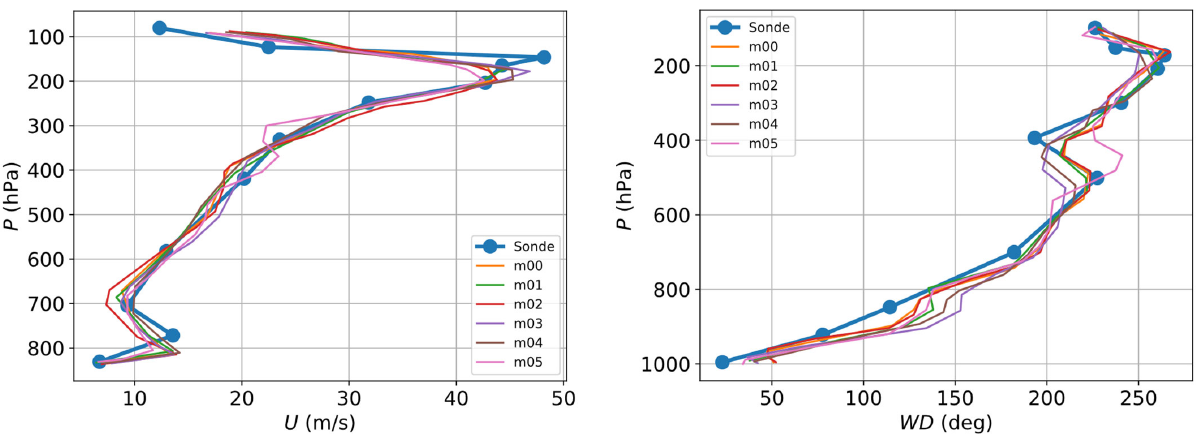
Figure 1. Comparison of the predictions by the mesoscale model and the weather balloons (sonde). The measurements were taken on 23 September 2019 at 00:00 UTC at the A Coruña airport. In addition to the validation against the weather balloon, a cross ‐ validation with the measurements obtained by the LiDAR and the METARs [39] at the airports listed in Er ‐ ror! Reference source not found. was performed. These places are wide open areas without vegetation, specifically selected in the surroundings of airports in order to measure the wind profiles by the weather balloons. The most typical distribution of the ground is asphalt or very low vegetation. The results of the validation can be found in